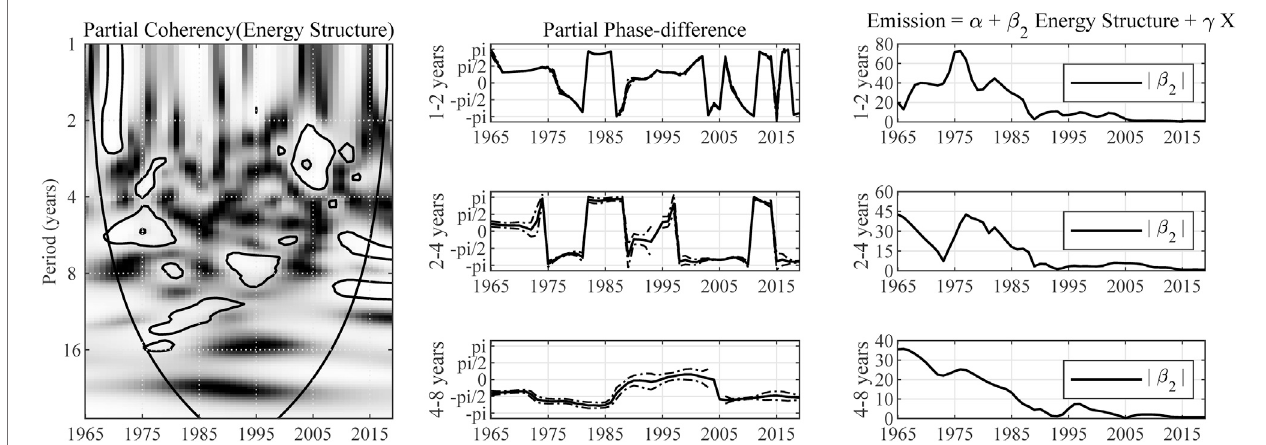
FIGURE 4 | Impact of energy structure on carbon emission in China. Note: The expression “ Partial Coherency (Energy Structure) ” denotes the partial coherency between energystructureand carbonemission,controlledforthein fl uencefromeconomicgrowthandtradeopenness.Theareasbelowthesymmetricblack convexcurve that appears in the fi gure ofcoherency are called the “ Cone ofIn fl uence (COI), ” in which the edge effects are profound. Inside the COI, the results tend to be unreliable. The contoursinthecoherencydiagramsindicate5%signi fi cancelevel,bootstrappedfor10,000replications.And,thebrightercolorscorrespondtohighersigni fi cancelevel, and darker colors correspond to lower signi fi cance level. The dotted lines accompanying the partial phase-difference indicate the 95% con fi dence